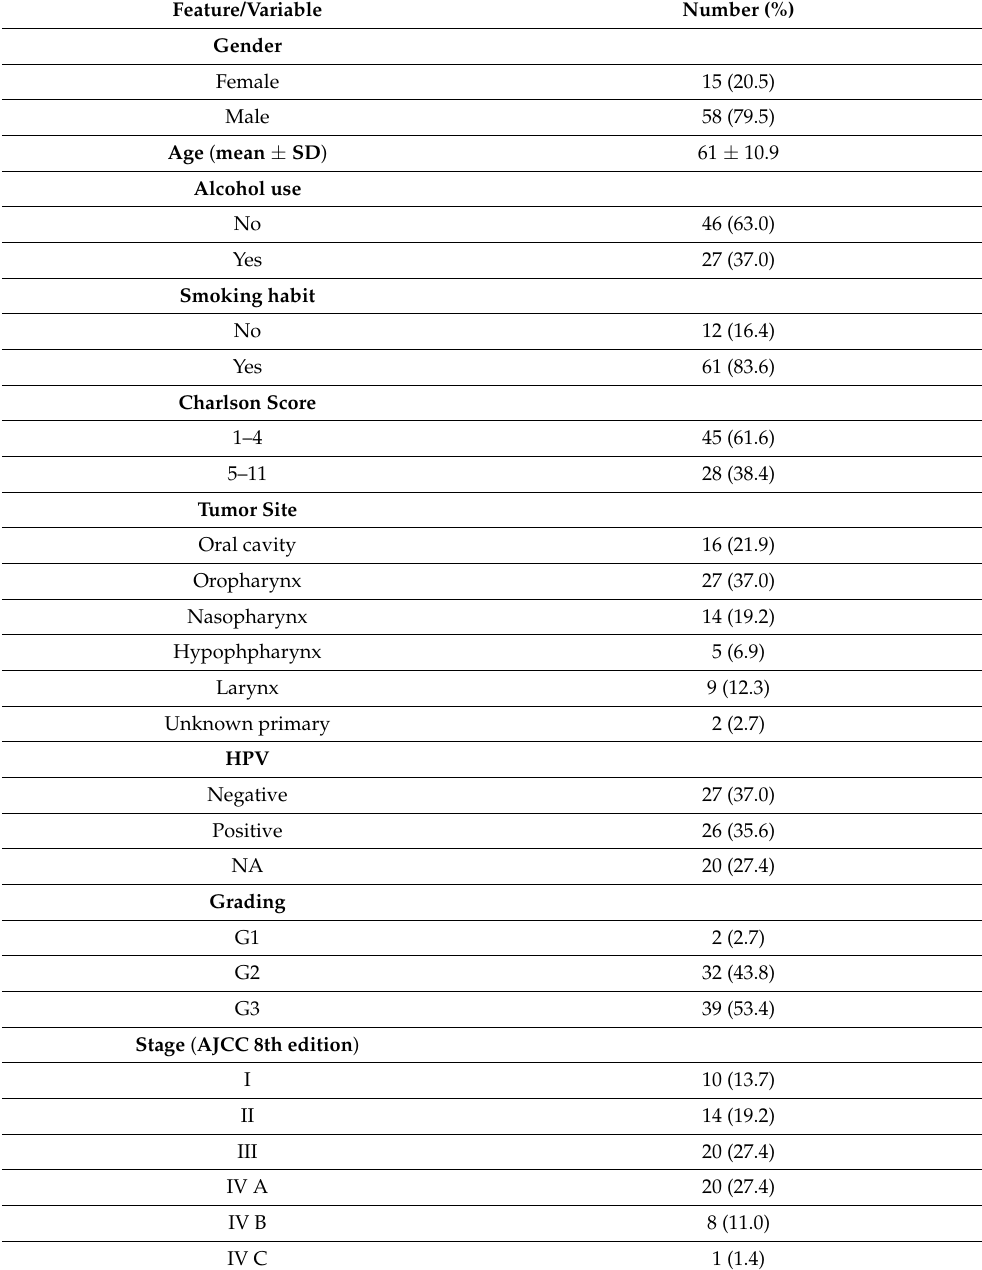
Table 1. Study population characteristics: in the first column—clinical aspects related to gender, habits, histology, staging, and grading; in the second column—number of patients and